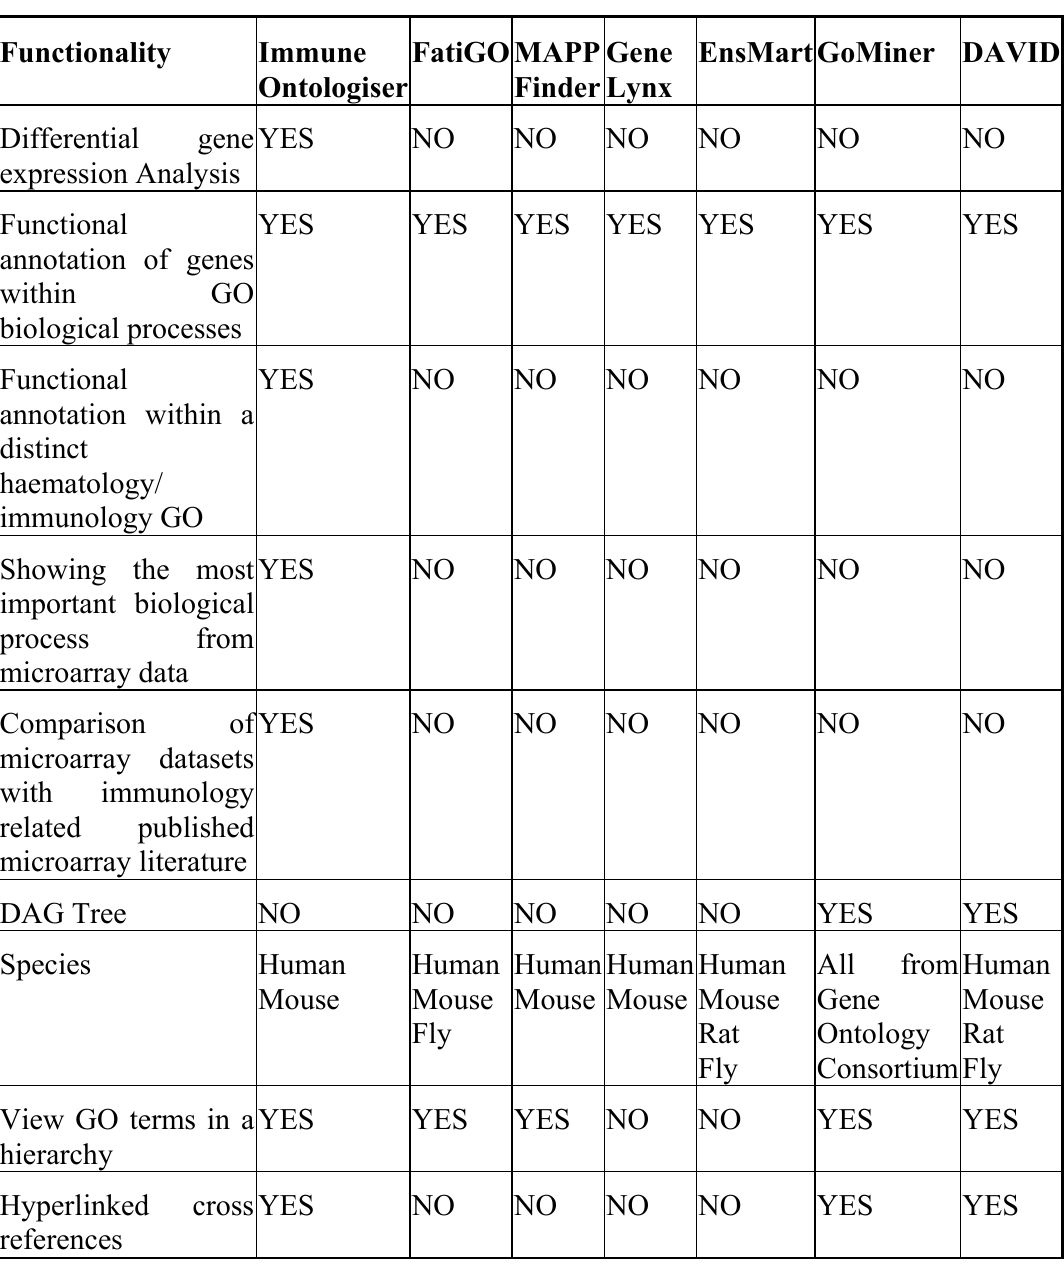
Table 4. Comparison of the Immune Ontologiser with similar